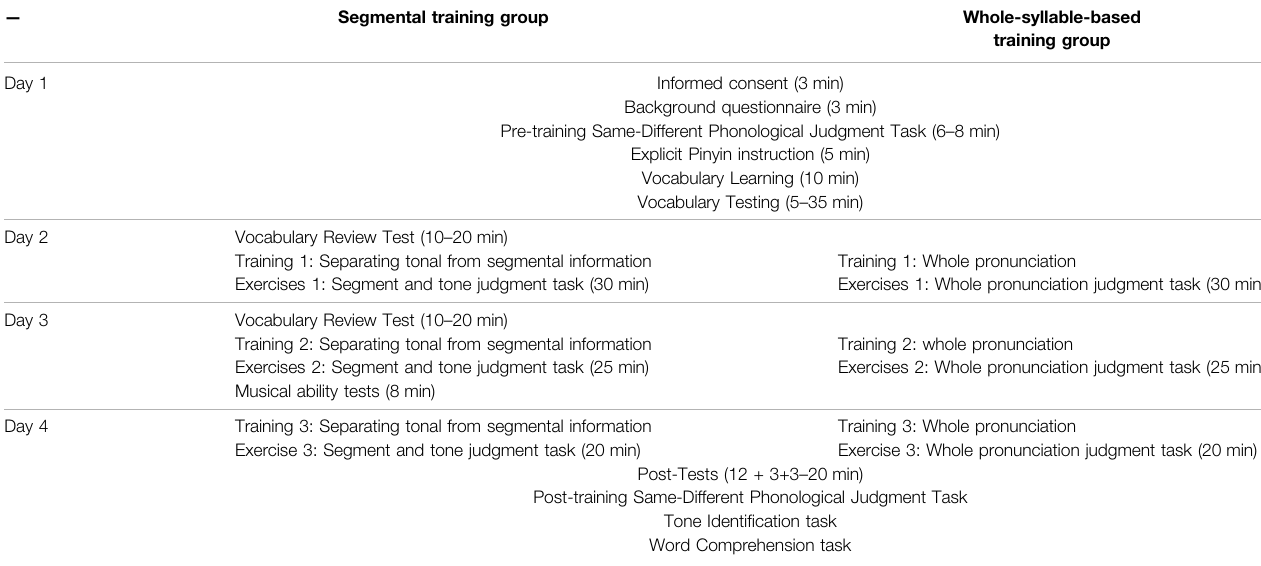
TABLE 1 | The training schedule for both groups. — Segmental training